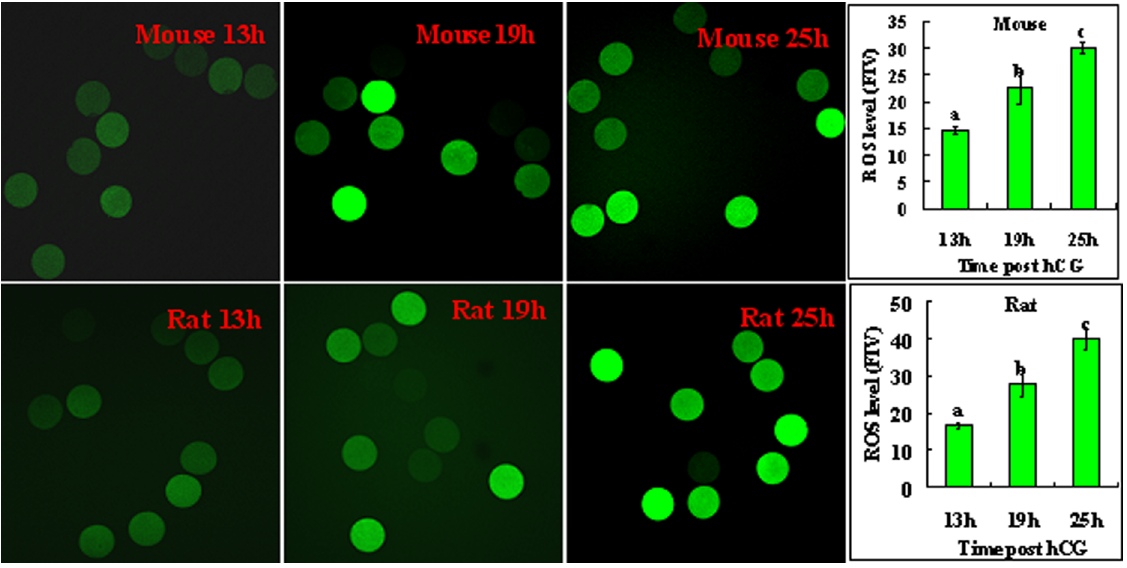
Figure 2. Levels of ROS (fluorescence intensity) in mouse and rat oocytes recovered at different times after hCG injection. The images show mouse or rat oocytes collected at 13 h, 19 h or 25 h after hCG injection. Oocytes were observed under a laser confocal microscope following DCHFDA staining. The graphs show the concentrations of ROS (fluorescence intensity value, FIV) in oocytes recovered at different times after hCG injection. Each treatment was repeated 3–4 times with each replicate containing about 30 oocytes. a,b,c: Values without a common letter in their bars differ (P , 0.05) within graphs.